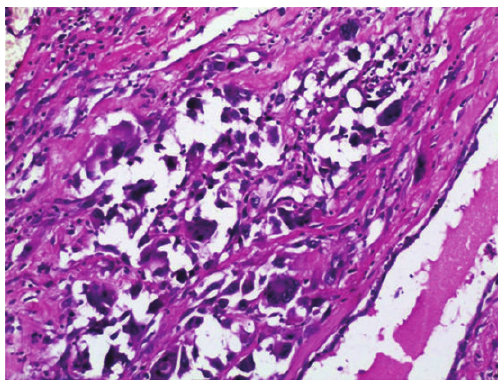
Figure 4: Malignant phyllodes tumor with multinucleated giant cells mimicking MFH; (H&E